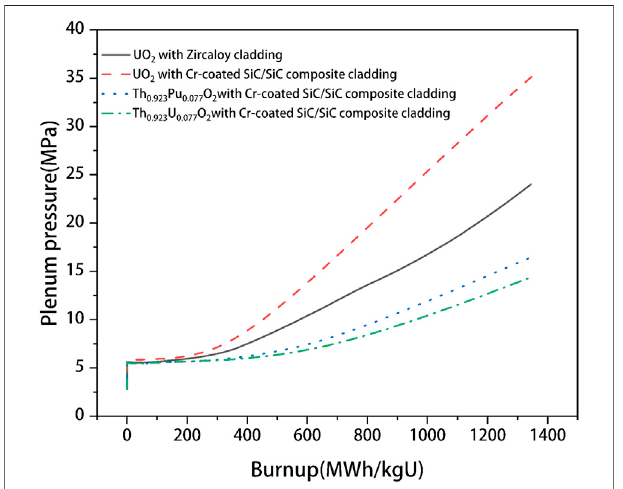
FIGURE 13 | Fission gas release evolutions for UO 2 fuel with Zircaloy cladding, the Th 0.923 Pu 0.077 O 2 fuel, and Th 0.923 U 0.077 O 2 fuel with Cr-coated SiC/SiC composite cladding under the normal operating condition.